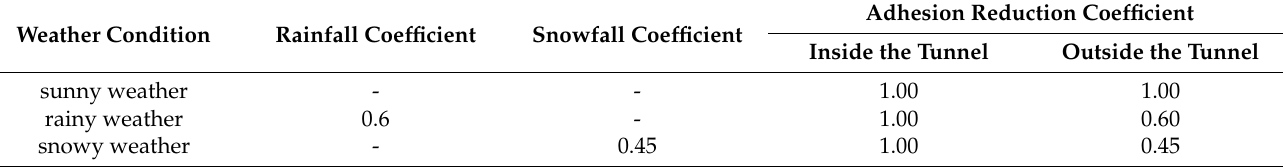
Table 2. Weather parameters set in SCANeR Studio TM